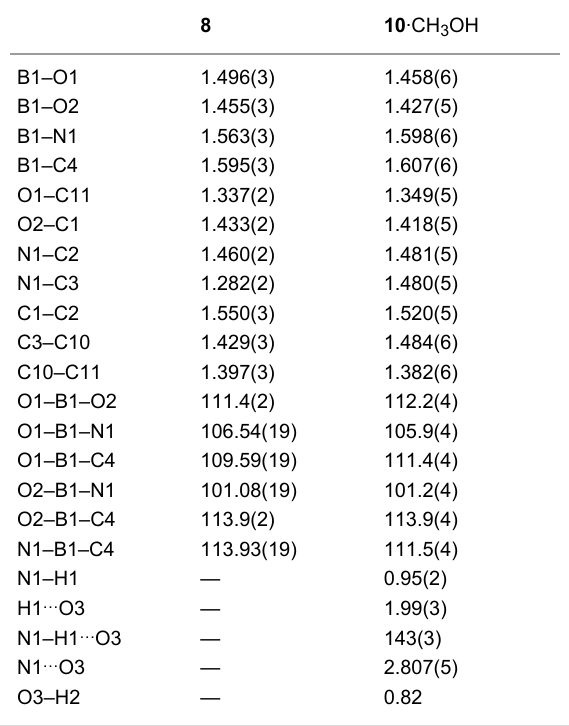
Table 1: Selected distances (Å) and angles (°) of compounds 8 and 10 ·CH 3 OH.